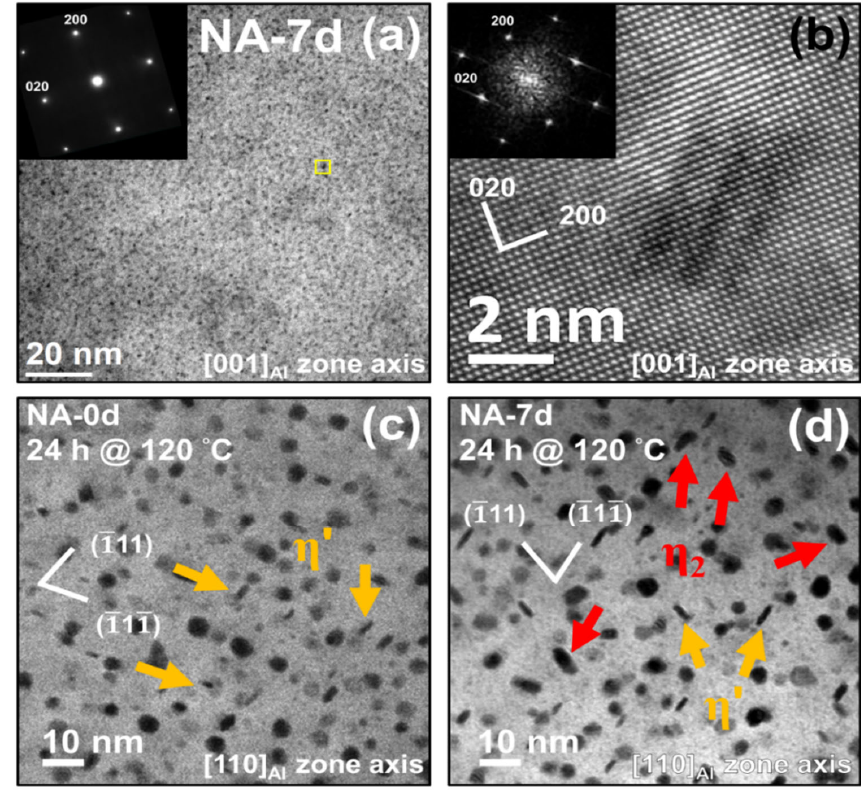
Figure 4. ( a ) TEM images of AA7075 naturally aged for 7 days and its diffraction pattern observed along the [001] Al zone axis. ( b ) HR-TEM image and the corresponding FFT of enlarged yellow square in ( a ). TEM images of ( c ) NA-0d and ( d ) NA-7d samples aged at 120 ◦ C for 24 h, observed along the [001] Al zone axis. The η ’ phase was marked by yellow arrows, while the η 2 phase was marked by red